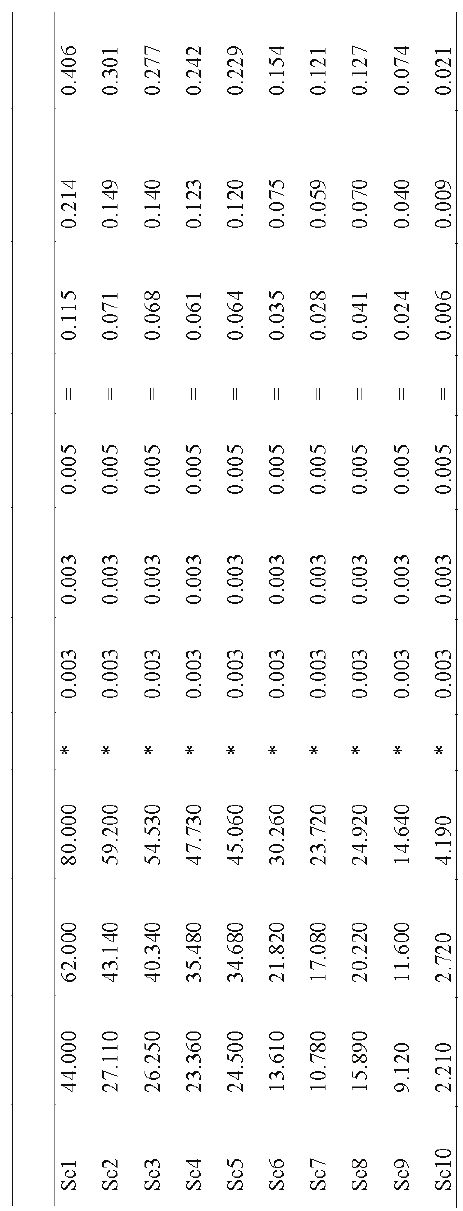
Table 5. Possibility for a convex fuzzy